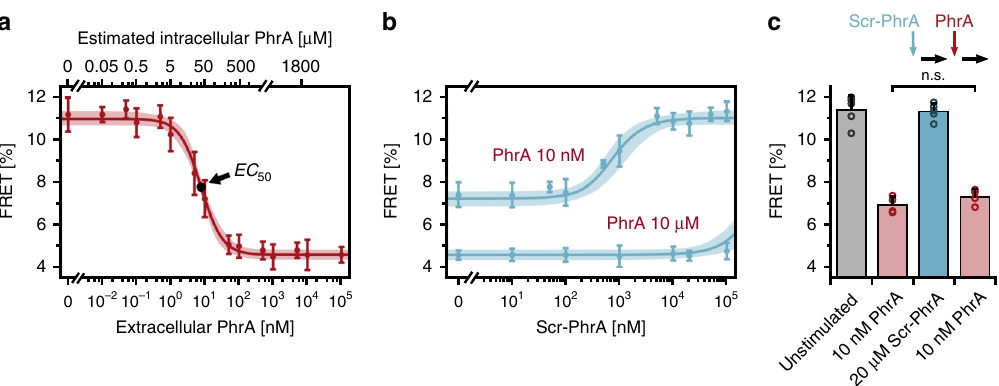
Fig. 5 Competition for substrate uptake inhibits PhrA signaling. a Response to increasing PhrA levels ( t s = 6 min). Data: mean ± SD from n e = 10. The curves (shaded areas) depict the best fi ts (95% con fi dence intervals) to the pump – probe model (see Fig. 6). The top axis denotes the intracellular PhrA concentrations as estimated by the model. b Competition for peptide uptake inhibits PhrA signaling. FRET response curve of reporter cells stimulated with 10 µ M and 10 nM PhrA in the presence of the indicated concentrations of a competing peptide, scrambled PhrA ( t s = 6 min). Data: mean ± SD from n e = 5. Lines and shaded areas denote best fi t and the 95% con fi dence interval to the pump – probe model. c Barplot of FRET values derived from a sequential stimulation experiment, including individual data points. Prior exposure of cells to 20 µ M Scr.-PhrA did not alter the response to 10 nM PhrA. Data: mean ± SD from n e = 4. Unpaired t test: P (0.21) > 0.05 (n.s.). See Supplementary Data 1 for further statistical information. Source data for all panels are provided as a Source Data fi le.